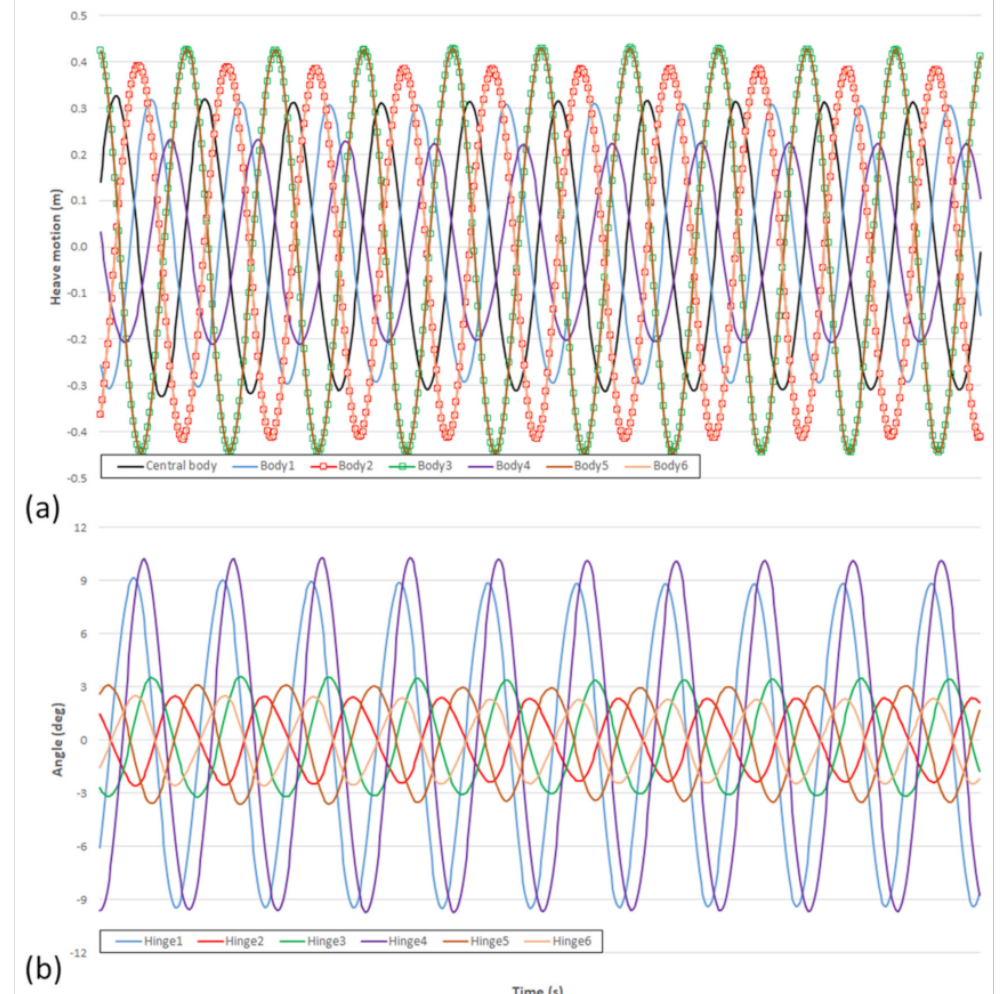
Figure 6. The ( a ) heave motion of the bodies and ( b ) hinge angles of the bodies at time T 4.8 s, an amplitude of 0.5 m and incident wave of 0 ◦